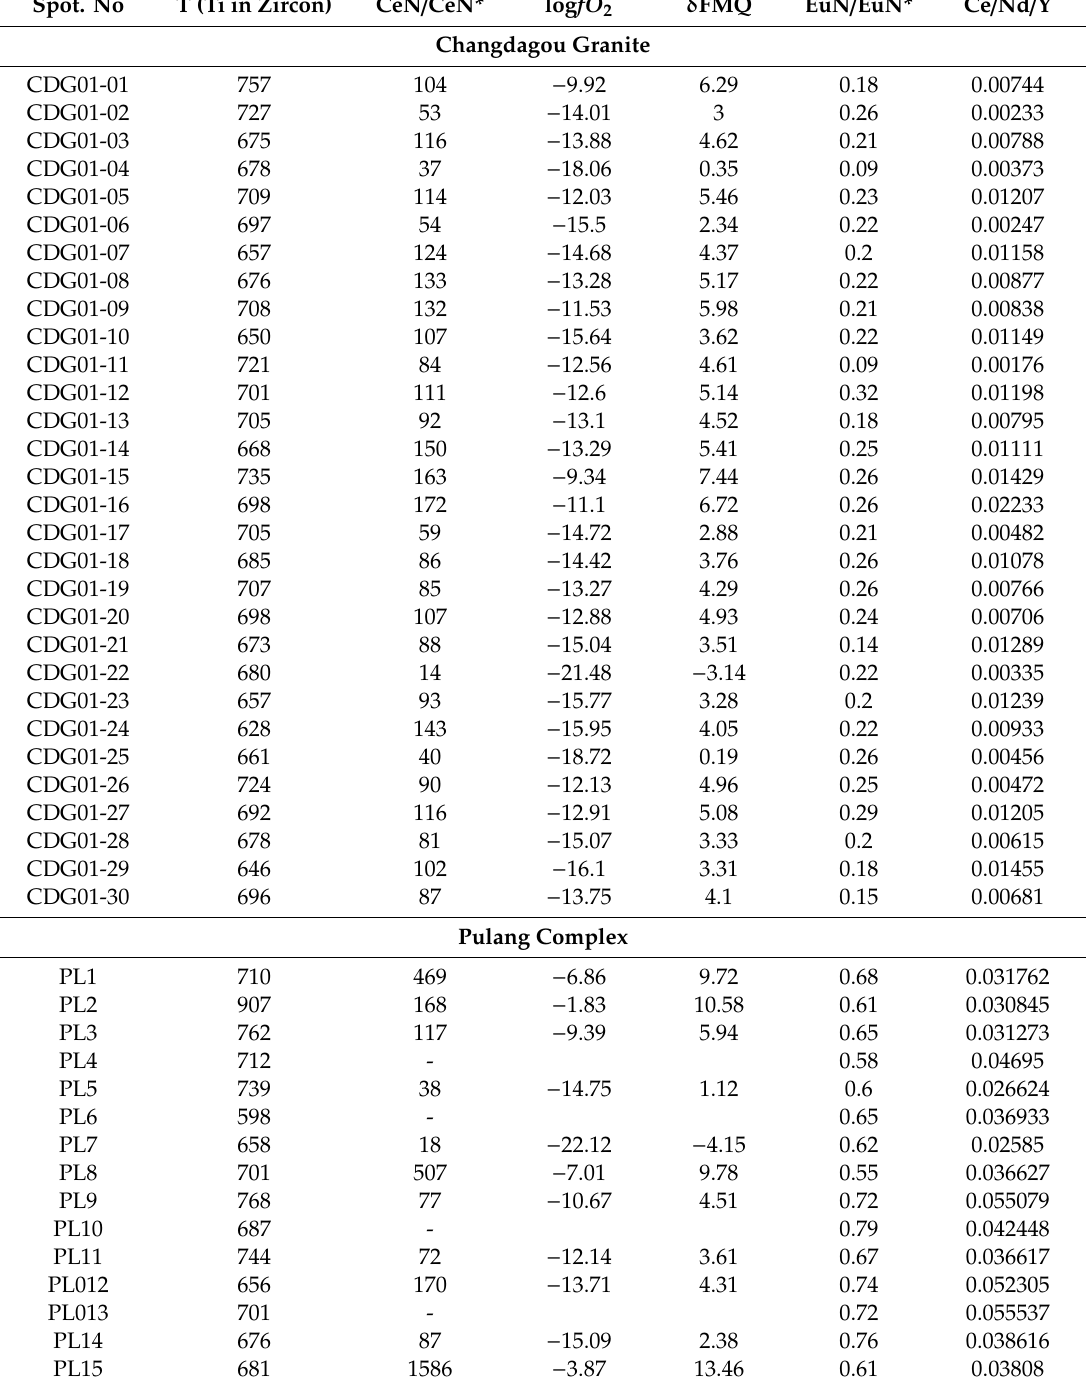
Table A1. Crystallization temperatures, Eu and Ce anomalies, and magma oxygen fugacity of zircon grains from Changdagou, Pulang, and Lannitang